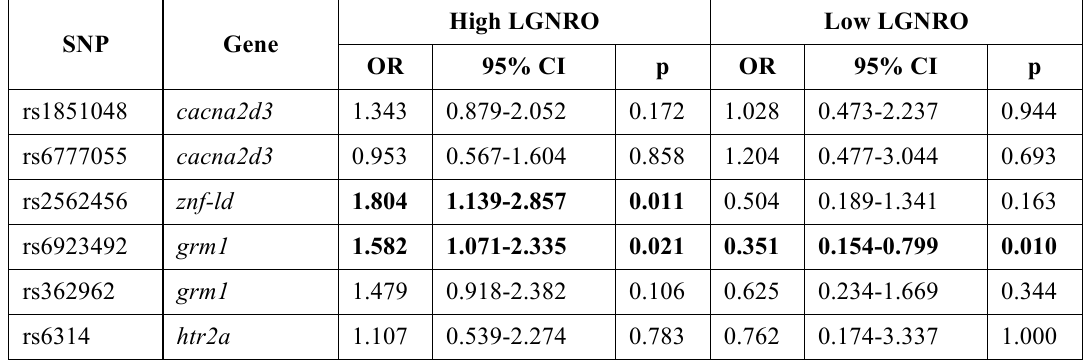
Table 6: Analysis of the frequency of occurrence of the studied SNPs with the level of reactivity High LGNRO Low LGNRO SNP Gene OR 95% CI p OR 95% CI p rs1851048 cacna2d3 1.343